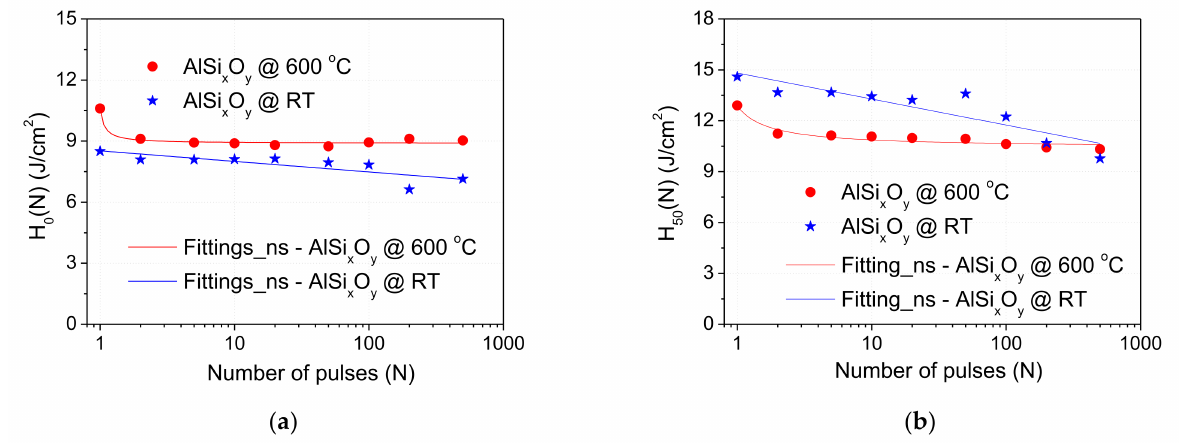
Figure 9. Damage probabilities energies densities reported to the number of laser pulses applied per site for aluminium silicate samples: ( a ) H 0 (N) and ( b ) H 50